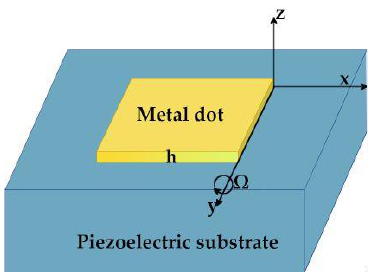
Figure 3. Solve object. Figure 3. Solve